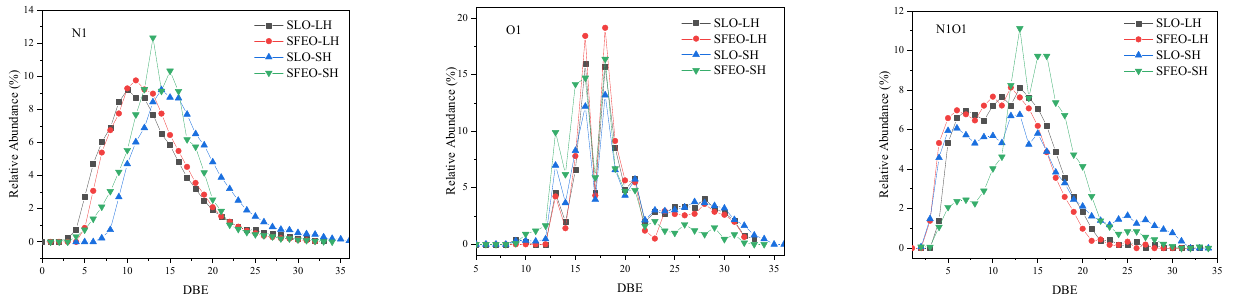
Figure 11. Relative abundance distribution of DBE for three species (N1, O1, N1O1) in SLO and SFEO (+ESI).